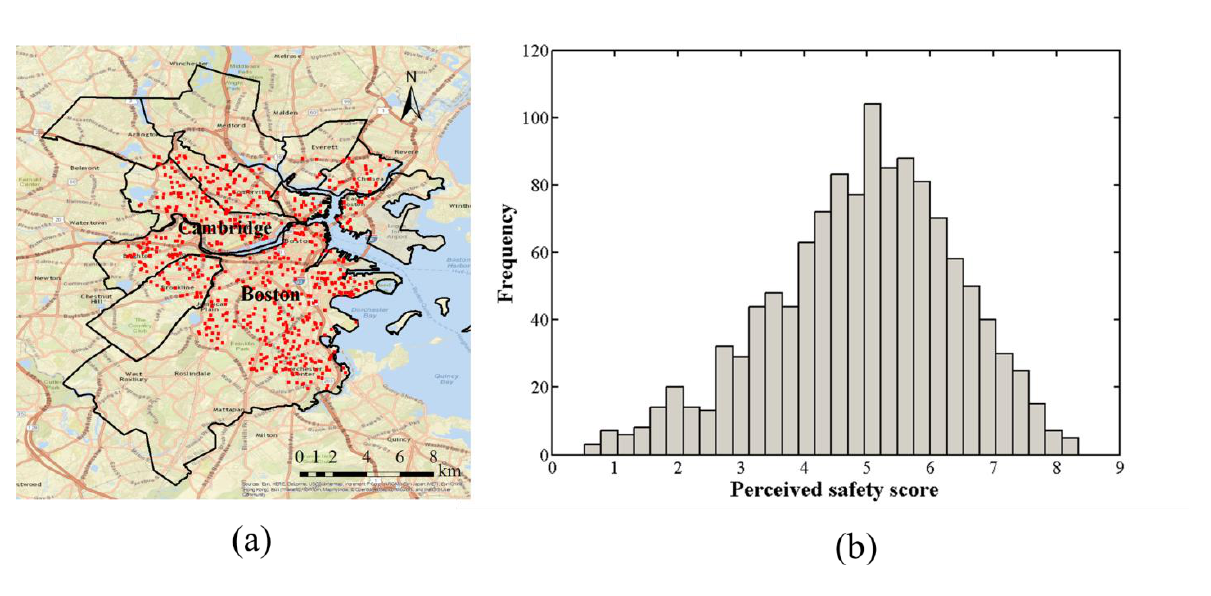
Figure 3. ( a ) The spatial distribution of Place Pulse image sites in Greater Boston. ( b ) Histogram of perceived safety scores in Greater